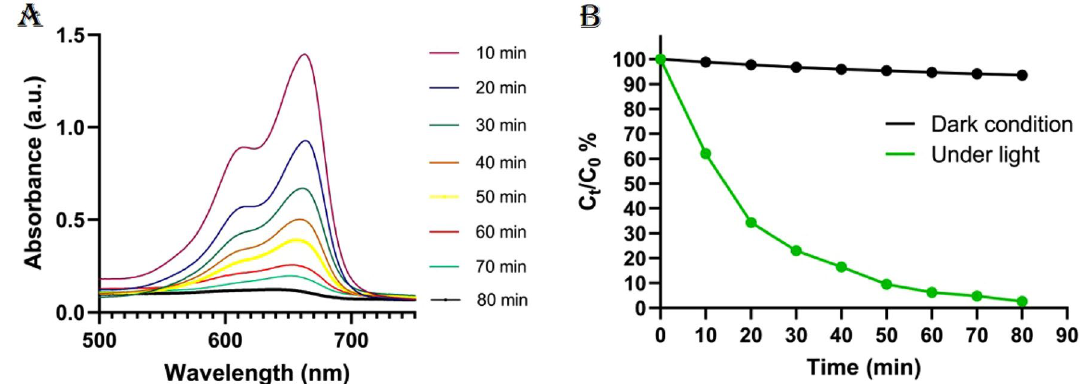
Figure 6. The CuO–NH 2 (nano)particles ( A ) photocatalytic activity on the methylene blue and ( B ) the efficiency of photodegradation under light or dark